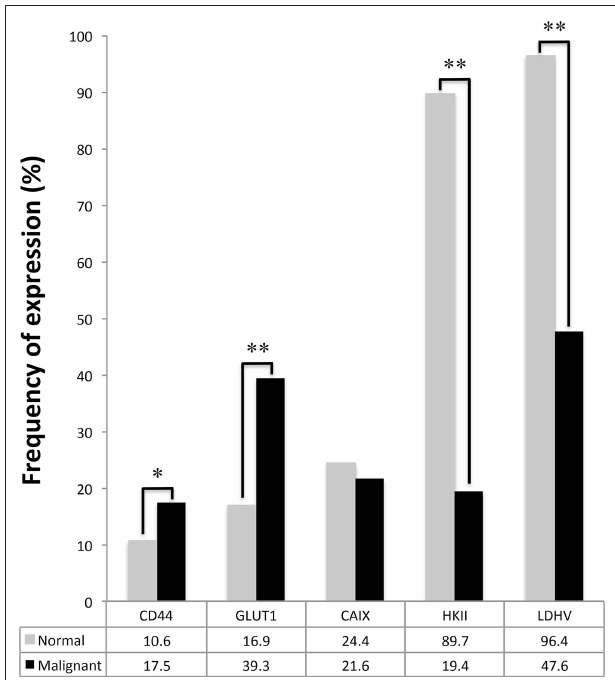
FIGURE 2 | Plasma membrane expression of GLUT1, CAIX, and CD44 and cytoplasmic expression of HKII and LDHV in adult testicular germ cell tumors and correspondent normal testicular tissues. McNemar’s test was used to assess differences of expression frequency between tumor and normal tissue. * p = 0.004, ** p <